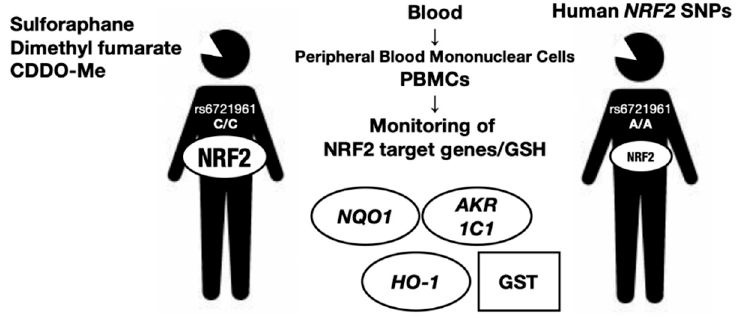
Figure 3. Monitoring of NRF2 activity in human blood samples. Human NRF2 rSNP, rs6721961, is located within an ARE motif 617 bp upstream from the transcription start site of the NRF2 gene. The minor A/A homozygote diminishes NRF2 gene expression by 40% compared with the C/C homozygote or C/A heterozygote. In diseases including cancers, chronic obstructive pulmonary disease (COPD), autism and multiple sclerosis, NRF2 activity is a potential biomarker for NRF2-inducers including sulforaphane, dimethyl fumarate and bardoxolone methyl (CDDO-Me) that can be monitored by glutathione (GSH) and NRF2 target genes.